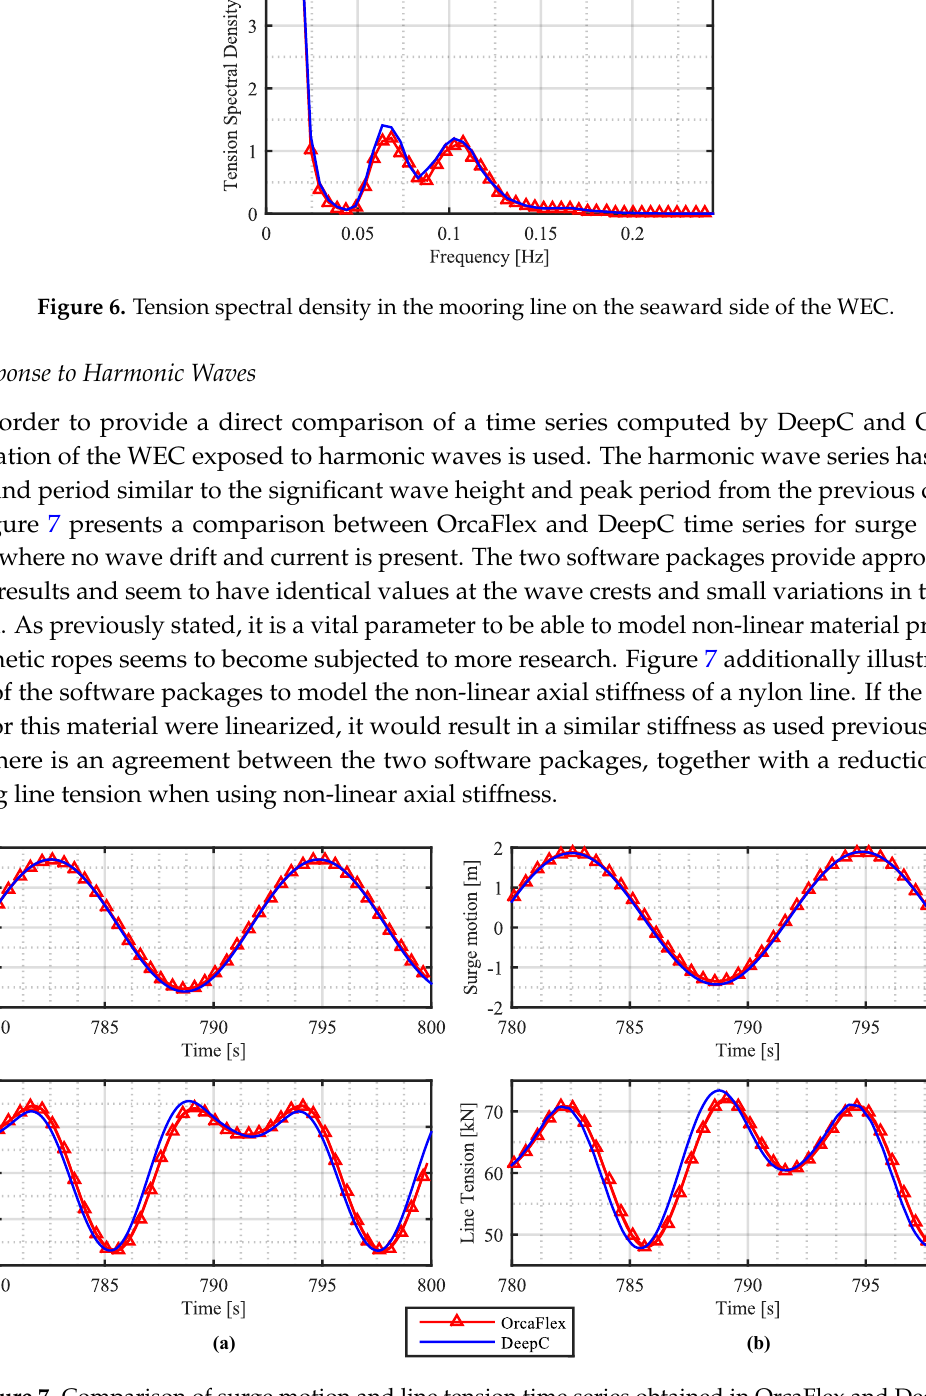
Figure 7. Comparison of surge motion and line tension time series obtained in OrcaFlex and DeepC. ( a ) is for linear axial stiffness of the lines, while ( b ) is for non-linear